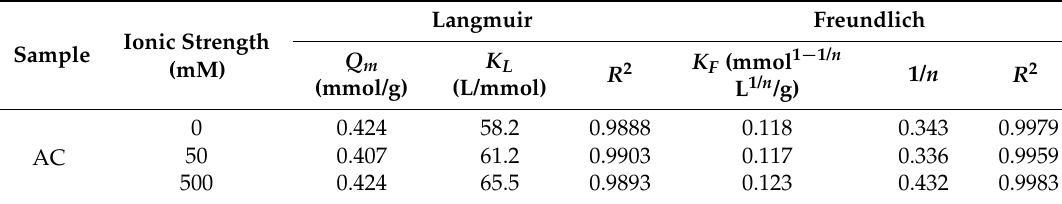
Table 5. Langmuir and Freundlich isotherm parameters for CAP adsorption by AC.